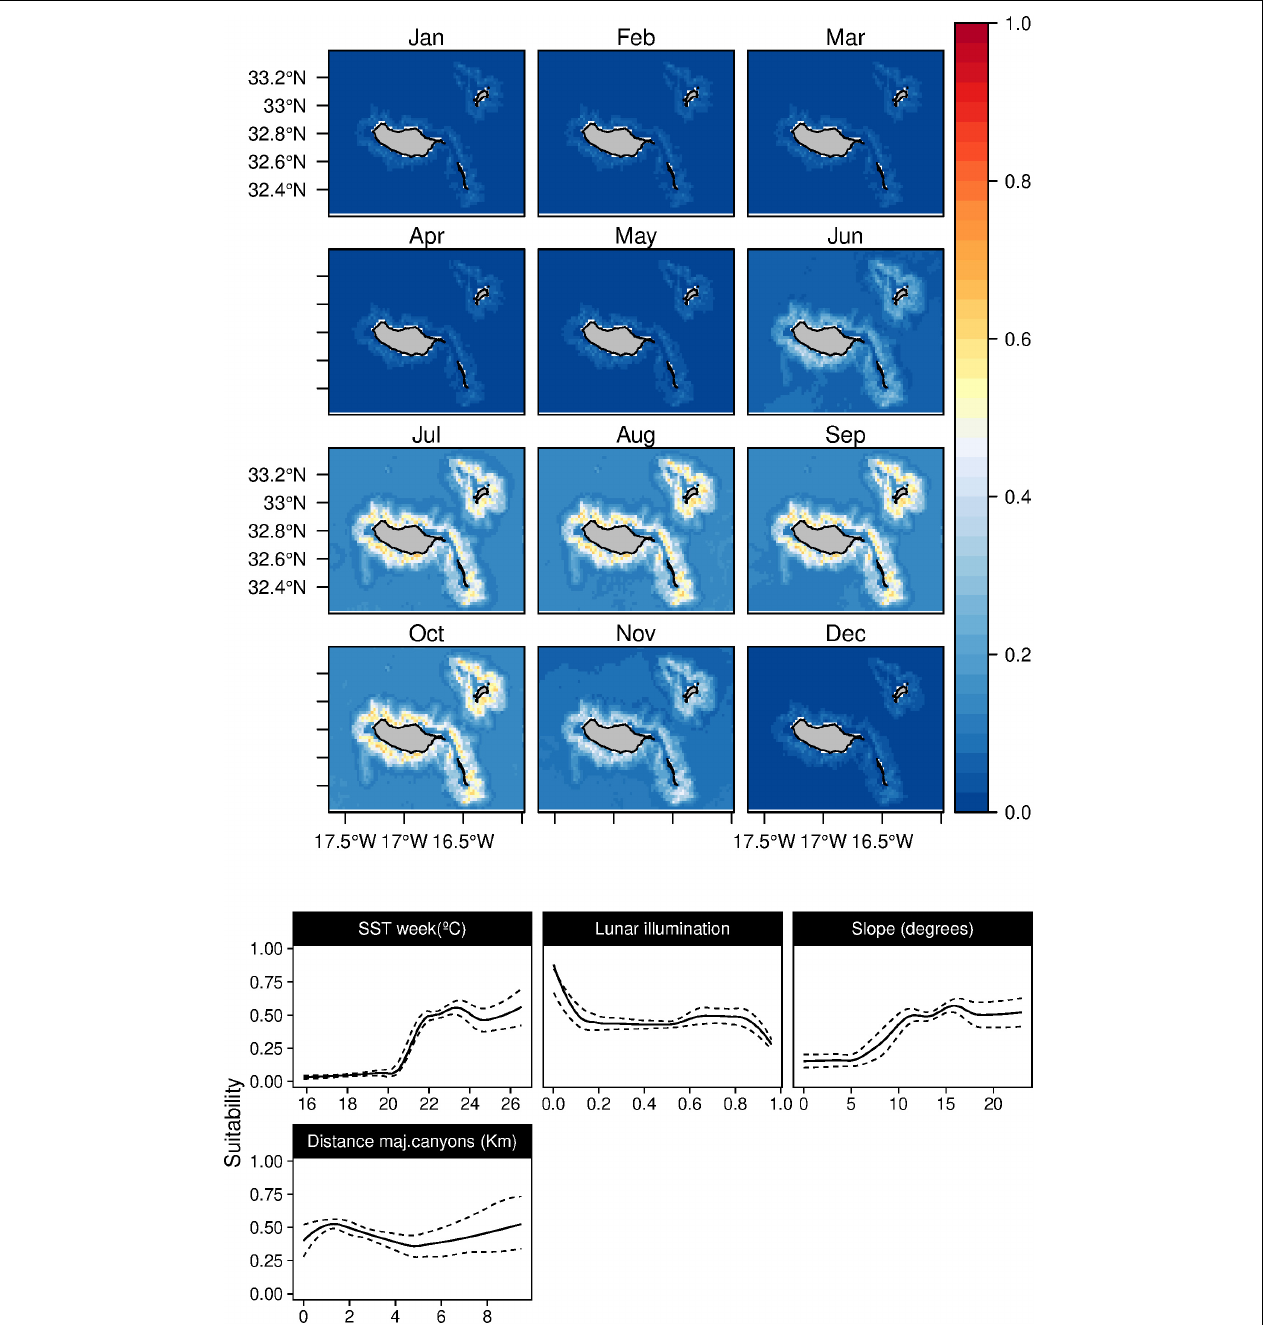
FIGURE 6 | Mean monthly suitability maps (above) and smoothed response curves with standard deviation (below) in the Madeira archipelago for Steno bredanensis for the “8-days” models. In the maps, red represents more suitable and blue less suitable. Responses curves are ordered by percent contribution of the environmental